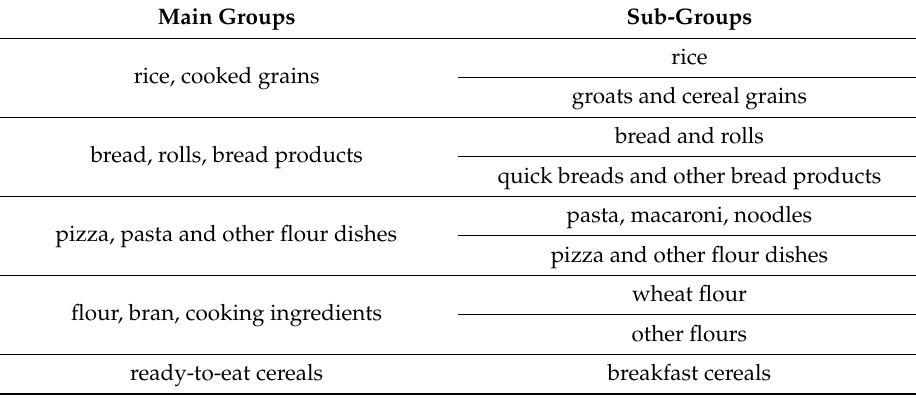
Table 1. Main groups and sub-groups in the category of cereals and cereal products.